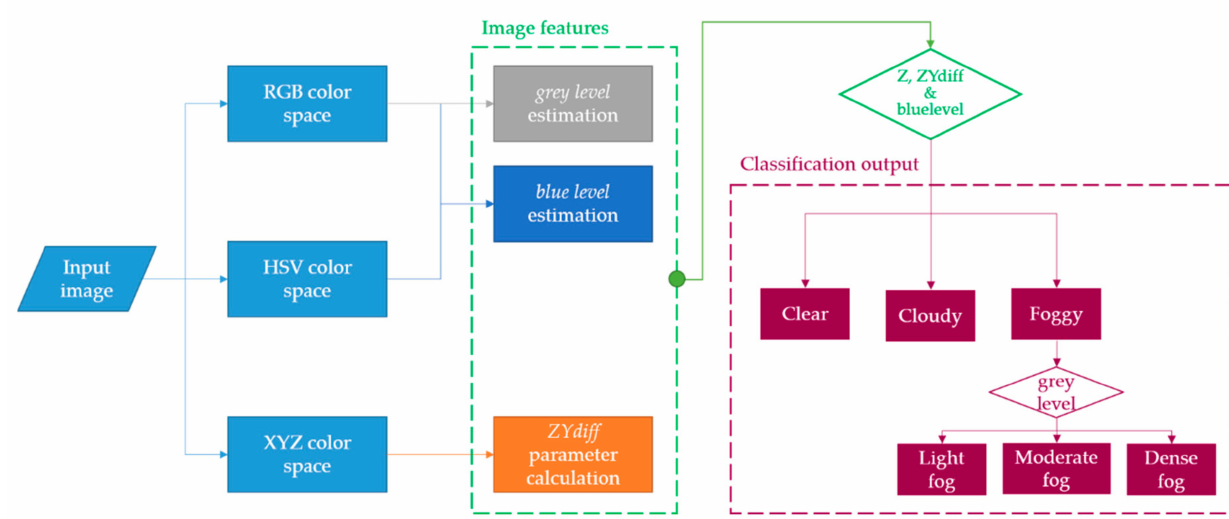
Figure 5. Methodology workflow implemented for the fog detection module.